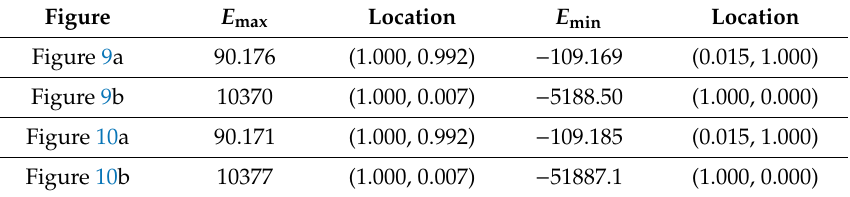
Figure 10. Same as that in Figure 9, except S t = 0.001. Table 2. Optimal values of vorticity along with its location in the cavity.